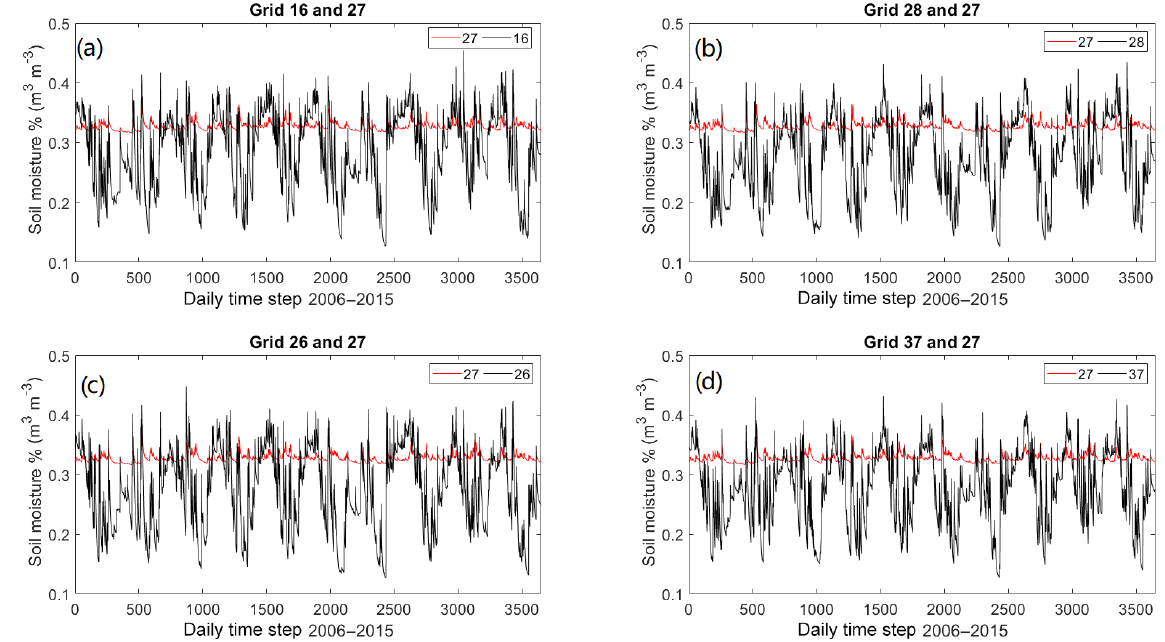
Figure 11. The soil moisture comparisons of Grid 27 with the adjacent grids (16, 28, 26,